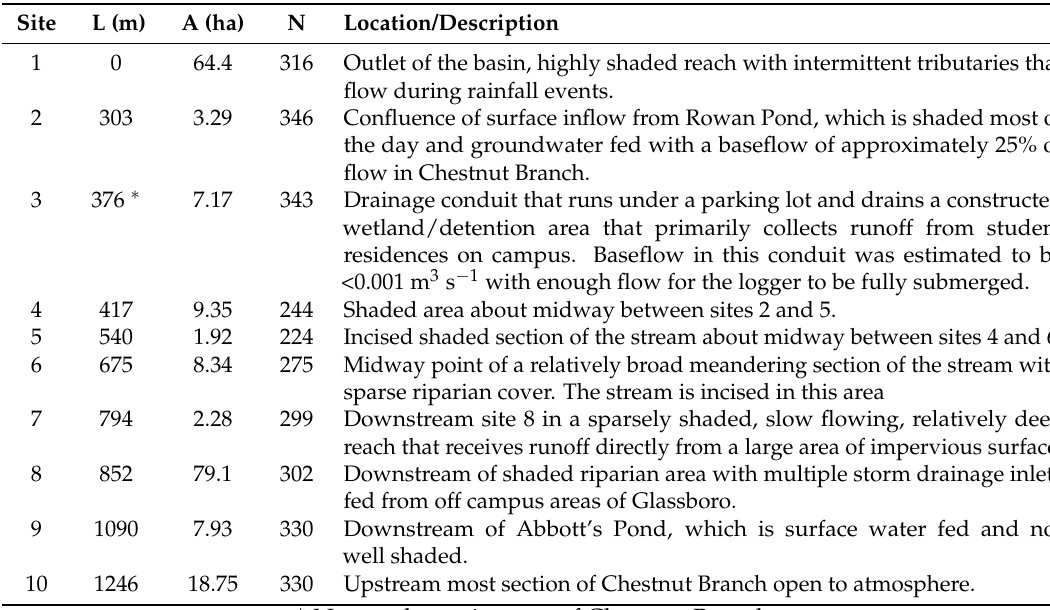
Table 1. Basin characteristics and description of site locations. Length, L, in meters of the location of the site upstream from the stream outlet at site 1. NA indicates that is not a temperature logger upstream of the site. Area, A, in hectares of drainage area for the basin delineated at the location of the logger. Sample size, N, indicating number of days with temperature readings at each